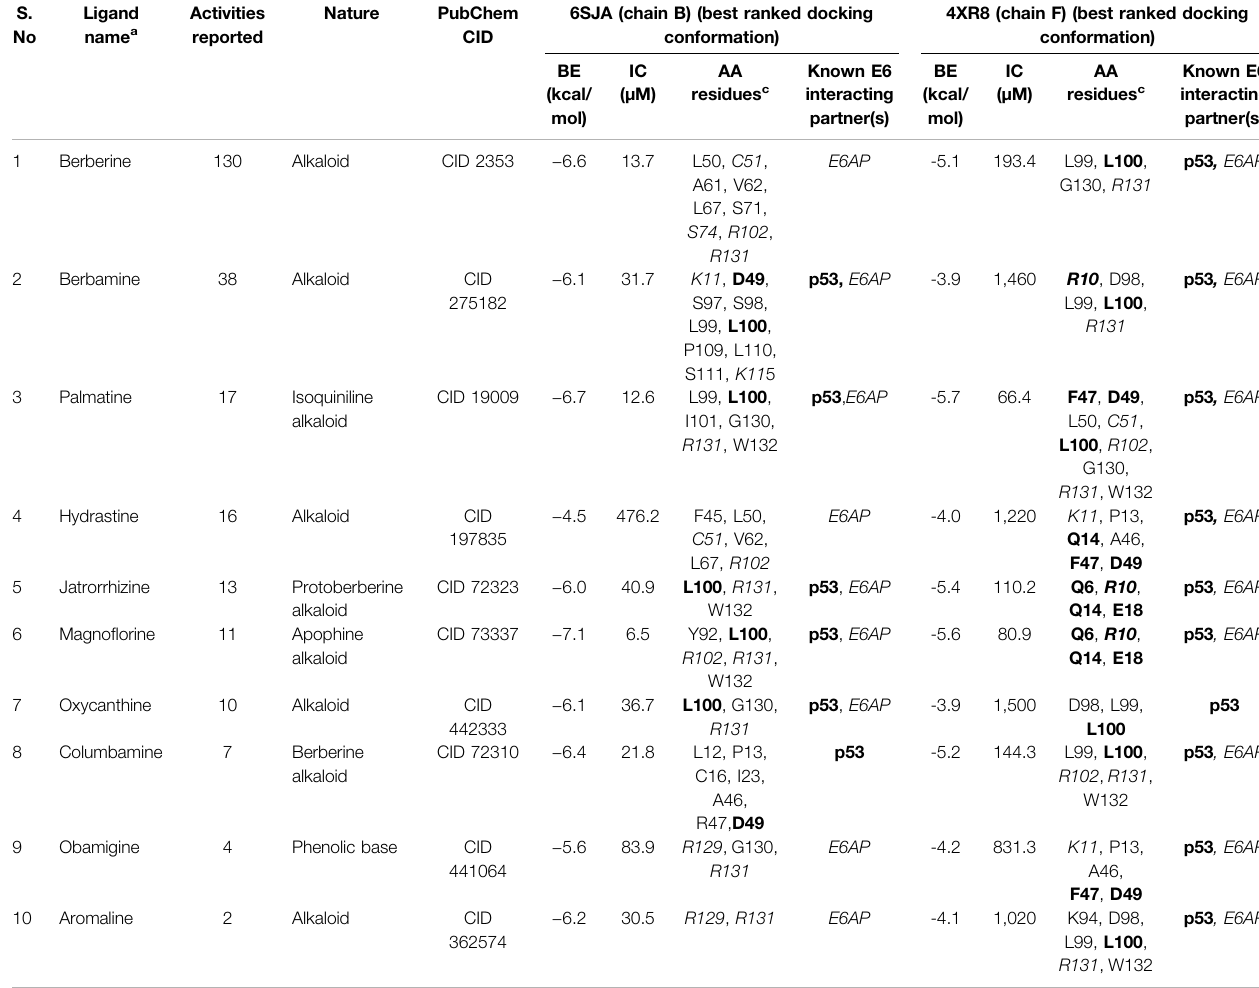
TABLE 1 | Molecular docking characteristics ofvarious phytochemicals reportedly present in root of B. aquifolium withthe 3D crystallographic structure ofHPV16 E6 (6SJA and 4XR8) available on PDB and their interacting amino acid residues with potential binding partners in the HPV16 E6 binding pocket. S.